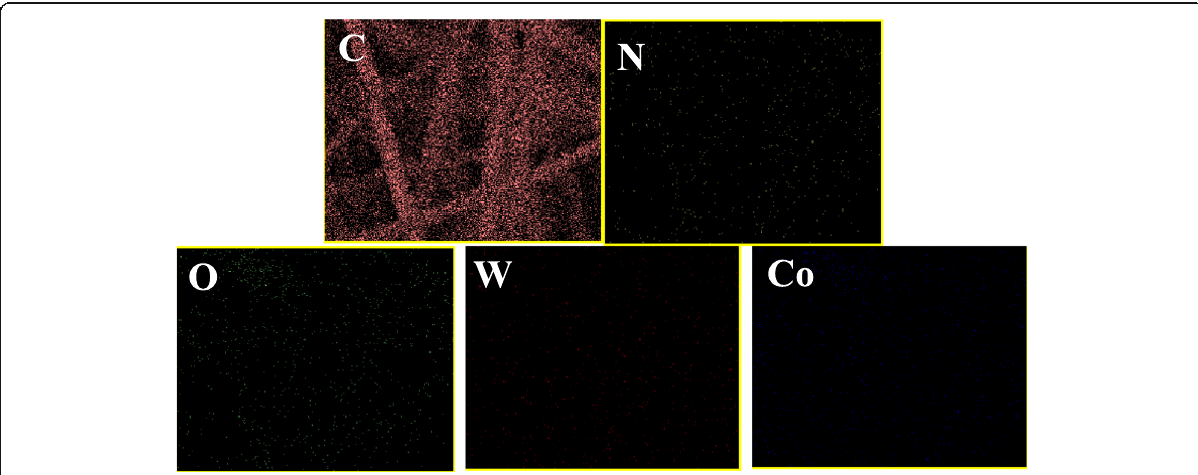
Fig. 6 Element mapping images of PAN/PS W 1 Co